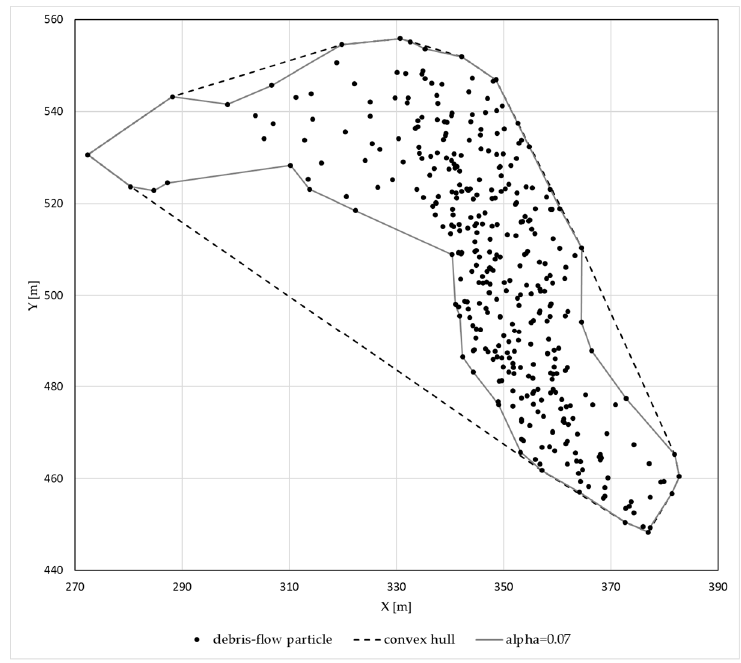
Figure 4. Comparison of the Convex Hull (dotted line) and the α -shape with alpha = 0.07 (solid line) over a selection of debris-flow particles.